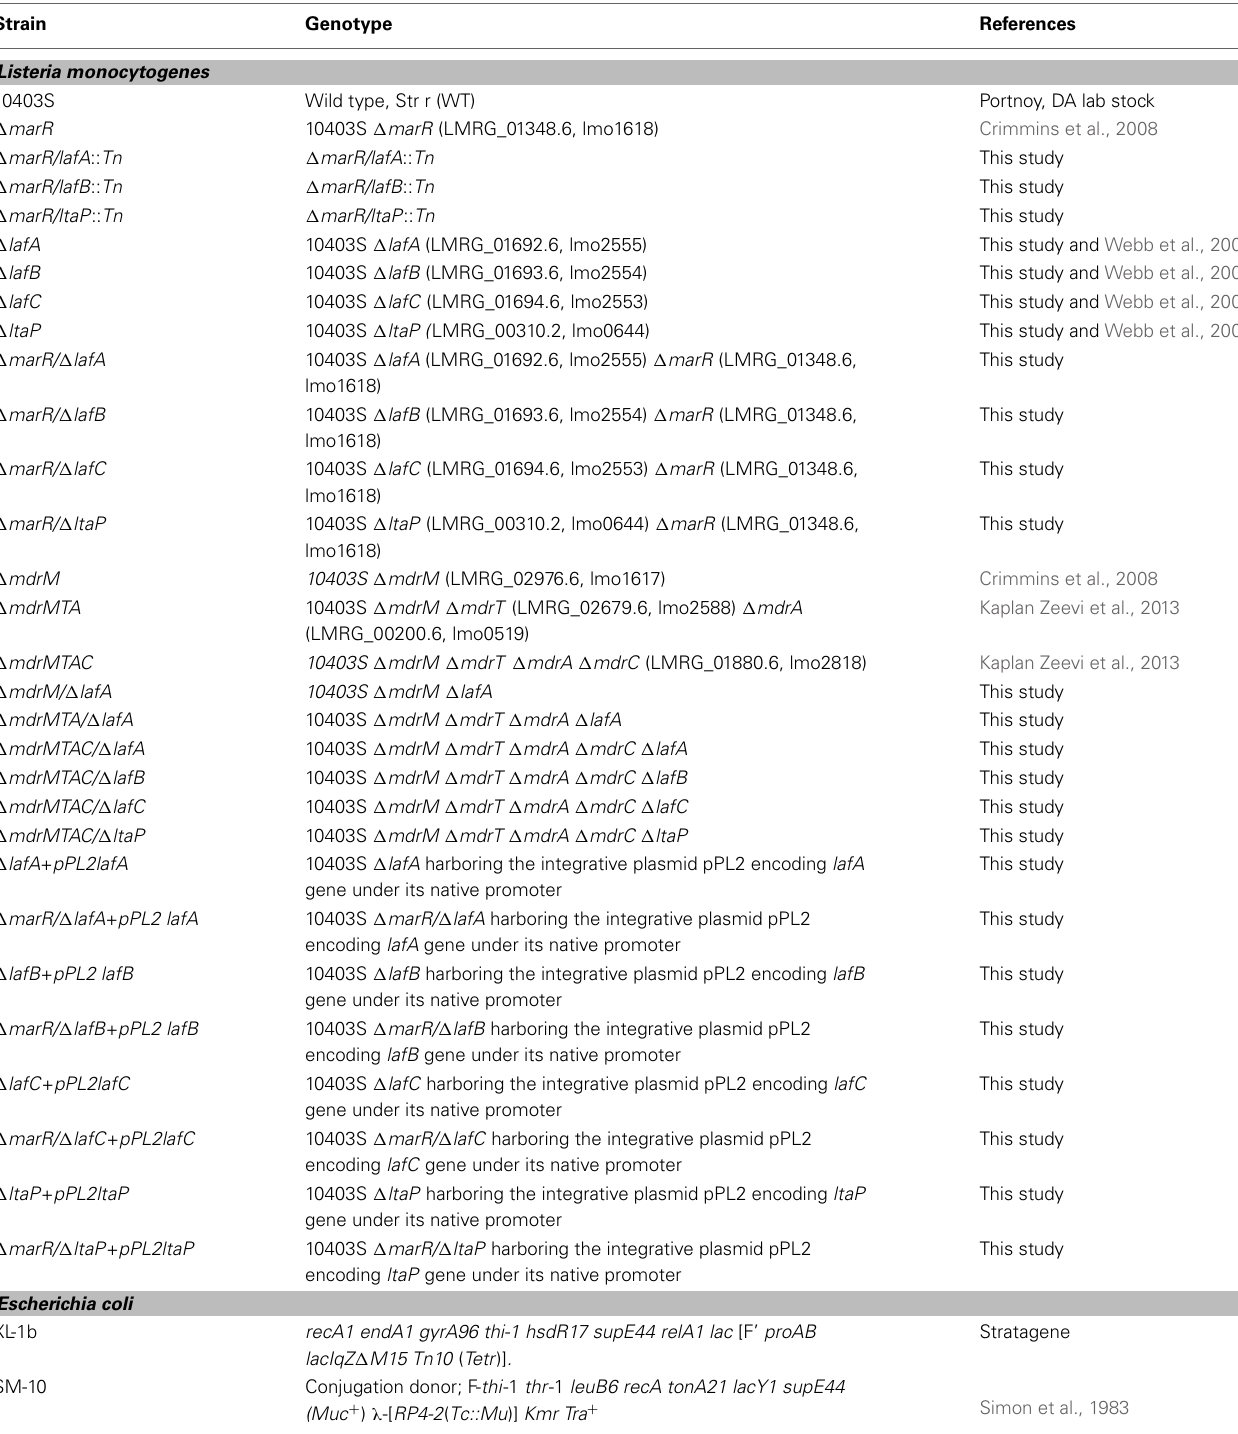
Table 2 | List of bacterial strains used in this study. Strain